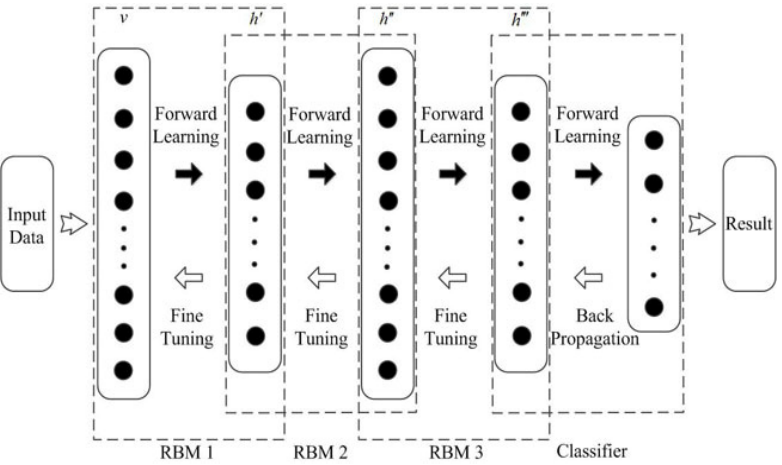
Figure 6. The structure diagram of a DBN.